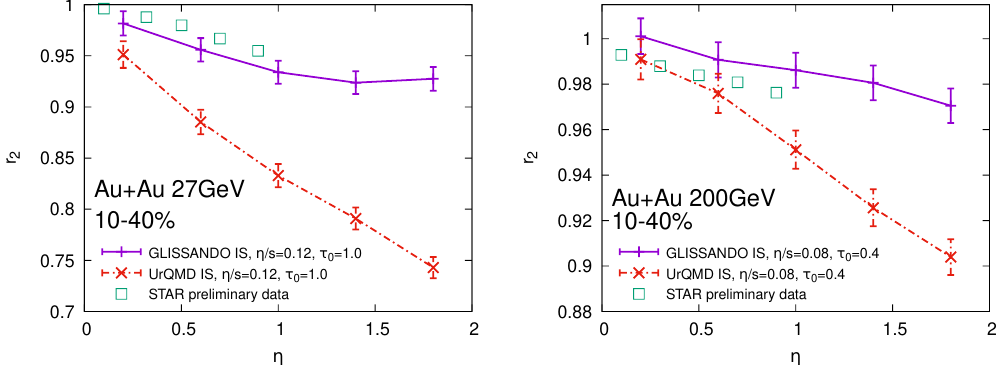
Figure 1: Pseudorapidity dependence of the factorization ratio r = 27 (left) and 200 GeV (right) compared with STAR preliminary collisions at (cid:112) s NN data [ 4,5 ] . Figure taken with permission from [ 6 ]